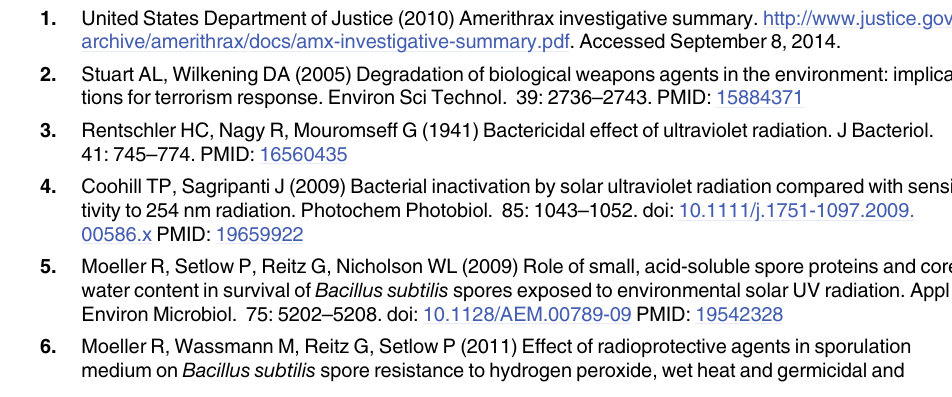
S1 Table. Inoculum and recovery data for each test of the entire